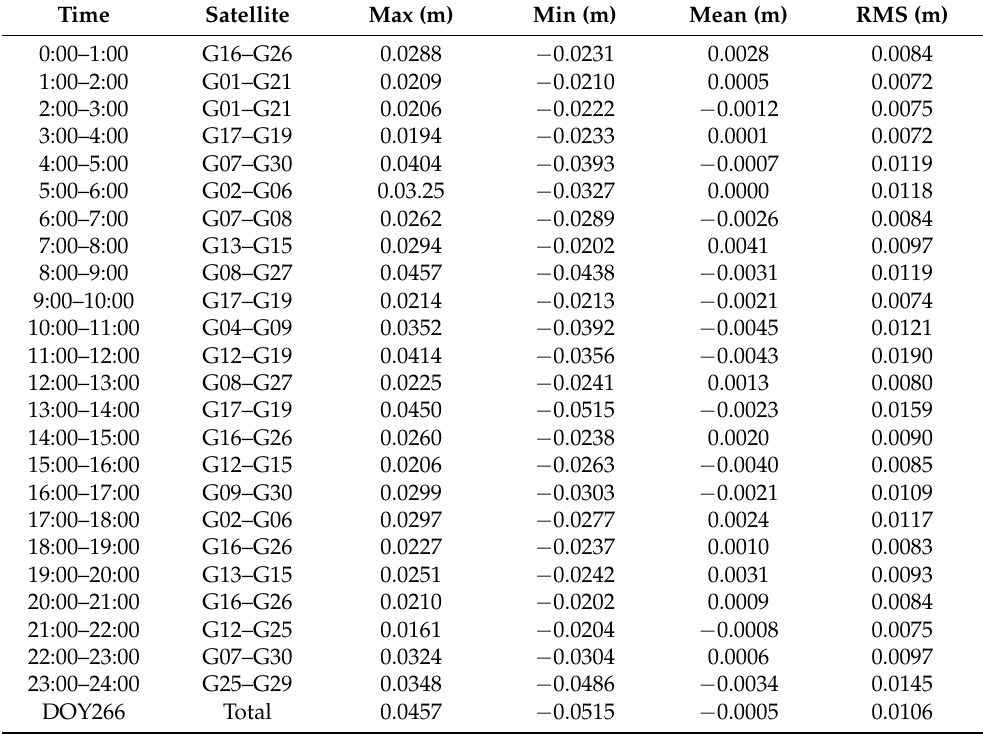
Table 8. Inter-satellite differential validation residuals.